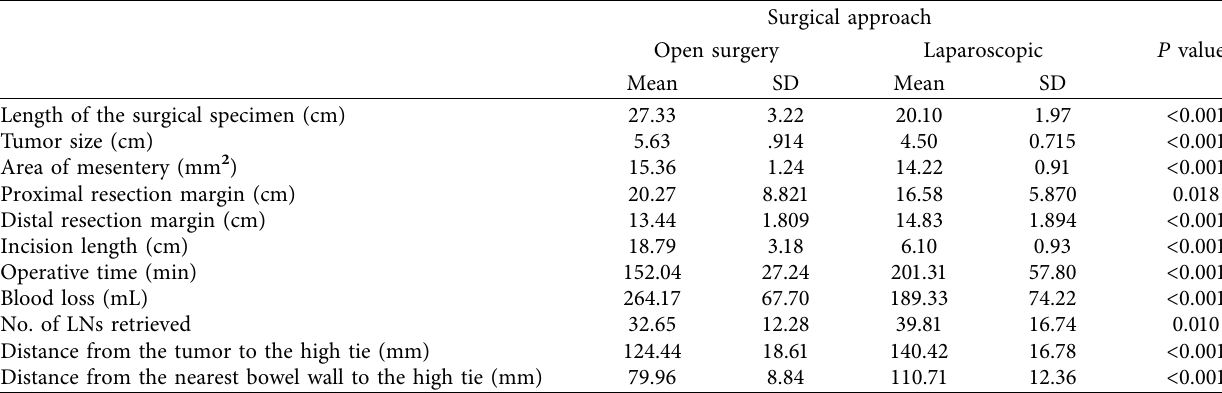
Table 2: Operative data and technical aspect according to the surgical approach.